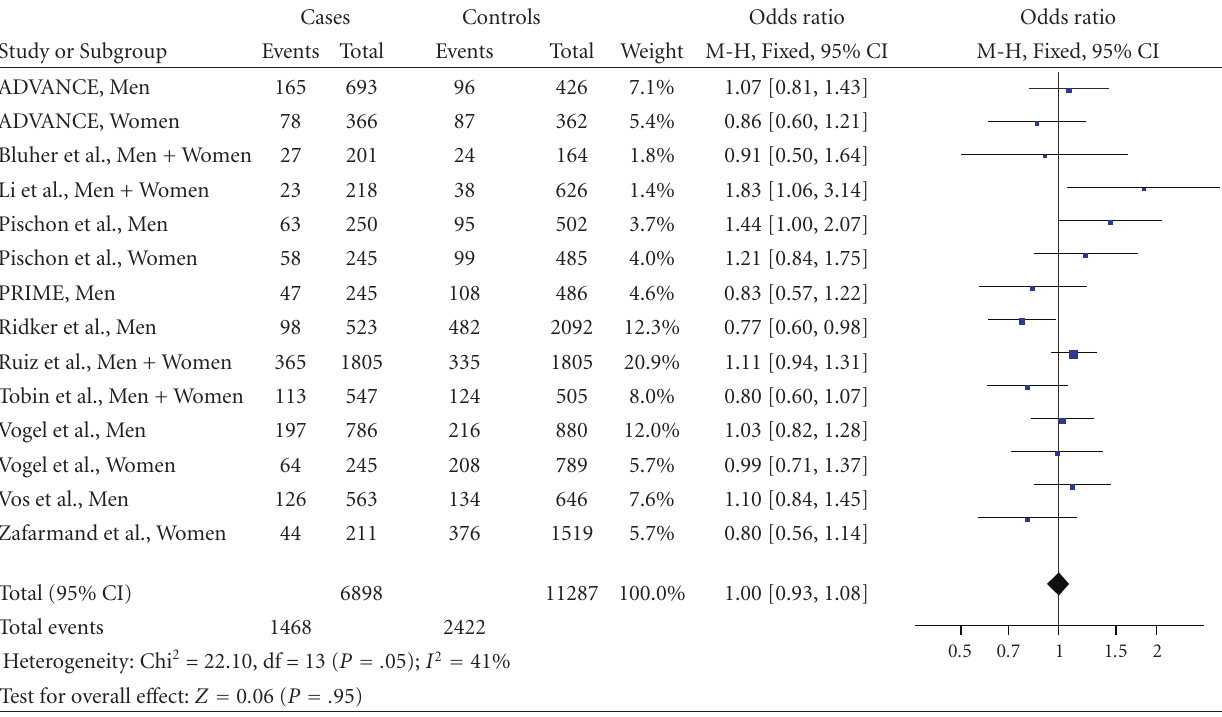
(a) Meta-analysis of CHD risk for the PPARG Pro12Ala polymorphism under the dominant model. Cases Controls Odds ratio Study or Subgroup